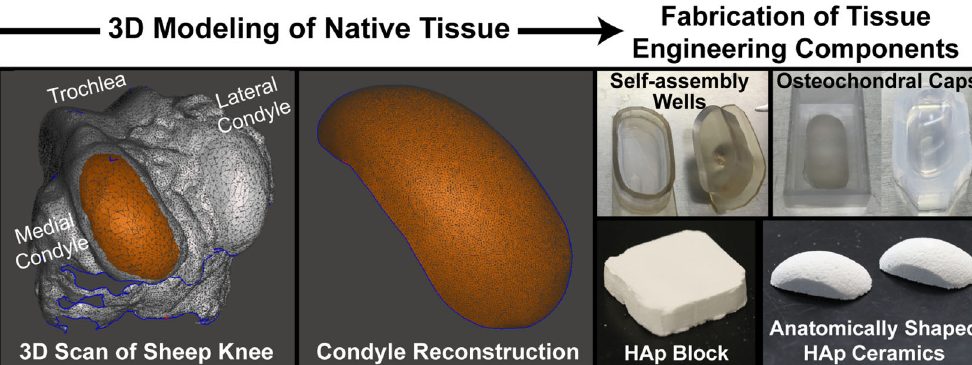
Fig. 7 Fabrication of HAp blocks and self-assembling wells. A laser-scanned, 3D model of ovine knees was used to create an anatomical surface of the medial femoral condyle. With this surface, appropriately shaped agarose molds and HAp ceramics were made. Two agarose molds were used for culturing the neocartilage: (1) self-assembly wells were made by adding agarose to a fl at-bottom, 3D-printed well and placing a negative cast on top; (2) osteochondral caps were made by adding agarose to a rectangular well containing a plastic reconstruction of the sheep medial condyle. HAp ceramics in the shape and size of the medial femoral condyle were made by machining a large HAp monolith to appropriate shapes with a CNC mill. HAp